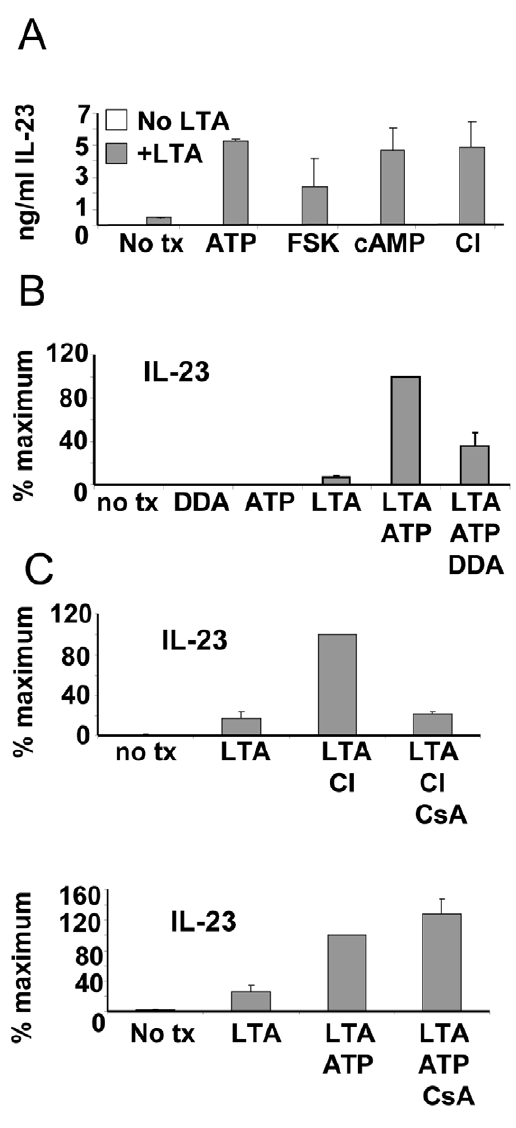
Figure 6. ATP enhances IL-23 production through an adenylate cyclase-dependent but not an ionotropic pathway. (A) Overnight cultures of monocytes were pre-treated with ATP, Forskolin (FSK), dibutyrl cyclic AMP (dbcAMP) or calcium ionophore A23187 (CI) prior to application of LTA. Culture supernatants were harvested 24 h later and analyzed by ELISA for IL-23. (B) Monocytes were treated for 30 min with the adenylate cyclase inhibitor dideoxyadenosine (DDA) prior to 4h ATP treatment. Cells were then activated with LTA and 24 h supernatants analyzed by ELISA for IL-23. (C) Monocytes were pre-treated with calcineurin-dependent phosphatase inhibitor, cyclosporine A (CsA) for 30 min prior to 4 h treatment with CI (upper panel) or ATP (lower panel). Cells were then activated with LTA. After 24 h culture supernatants were removed and analyzed for IL-23 by ELISA. Data from all panels derived from 3 separate experiments with different donors + / 2 SEM.